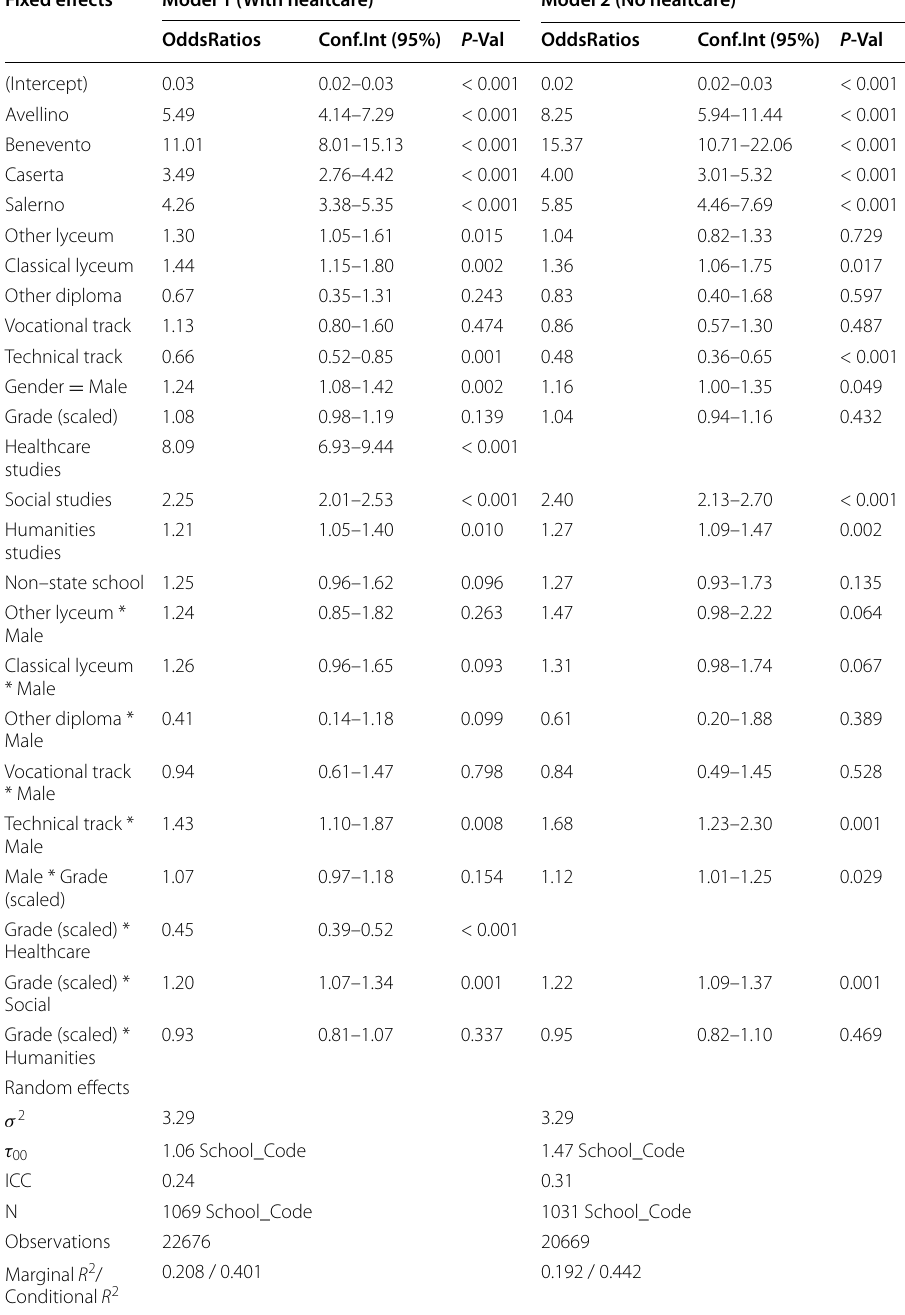
Table 6 Two multilevel logistic regression models: the first with students enrolled in healthcare programs, and the second